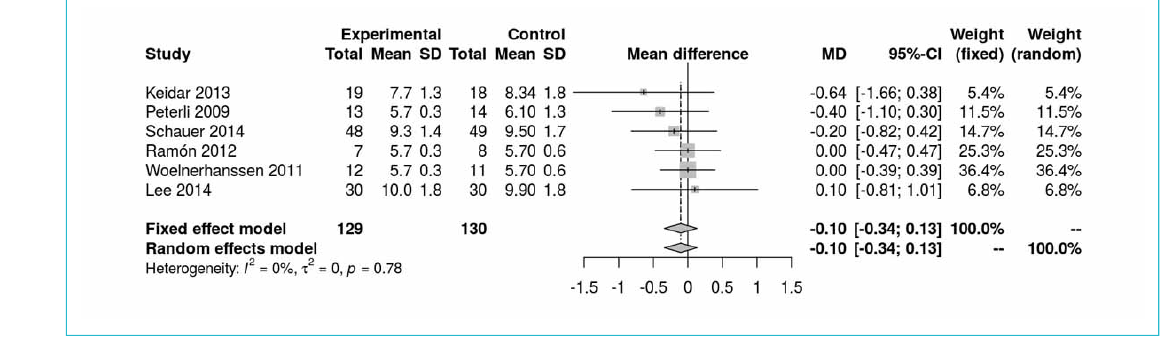
Figure 4a: Glycated haemoglobin (HbA1c) at